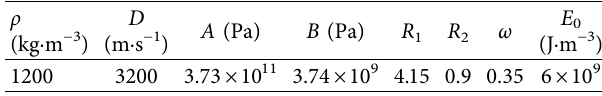
Table 2: Explosive materials and state equation